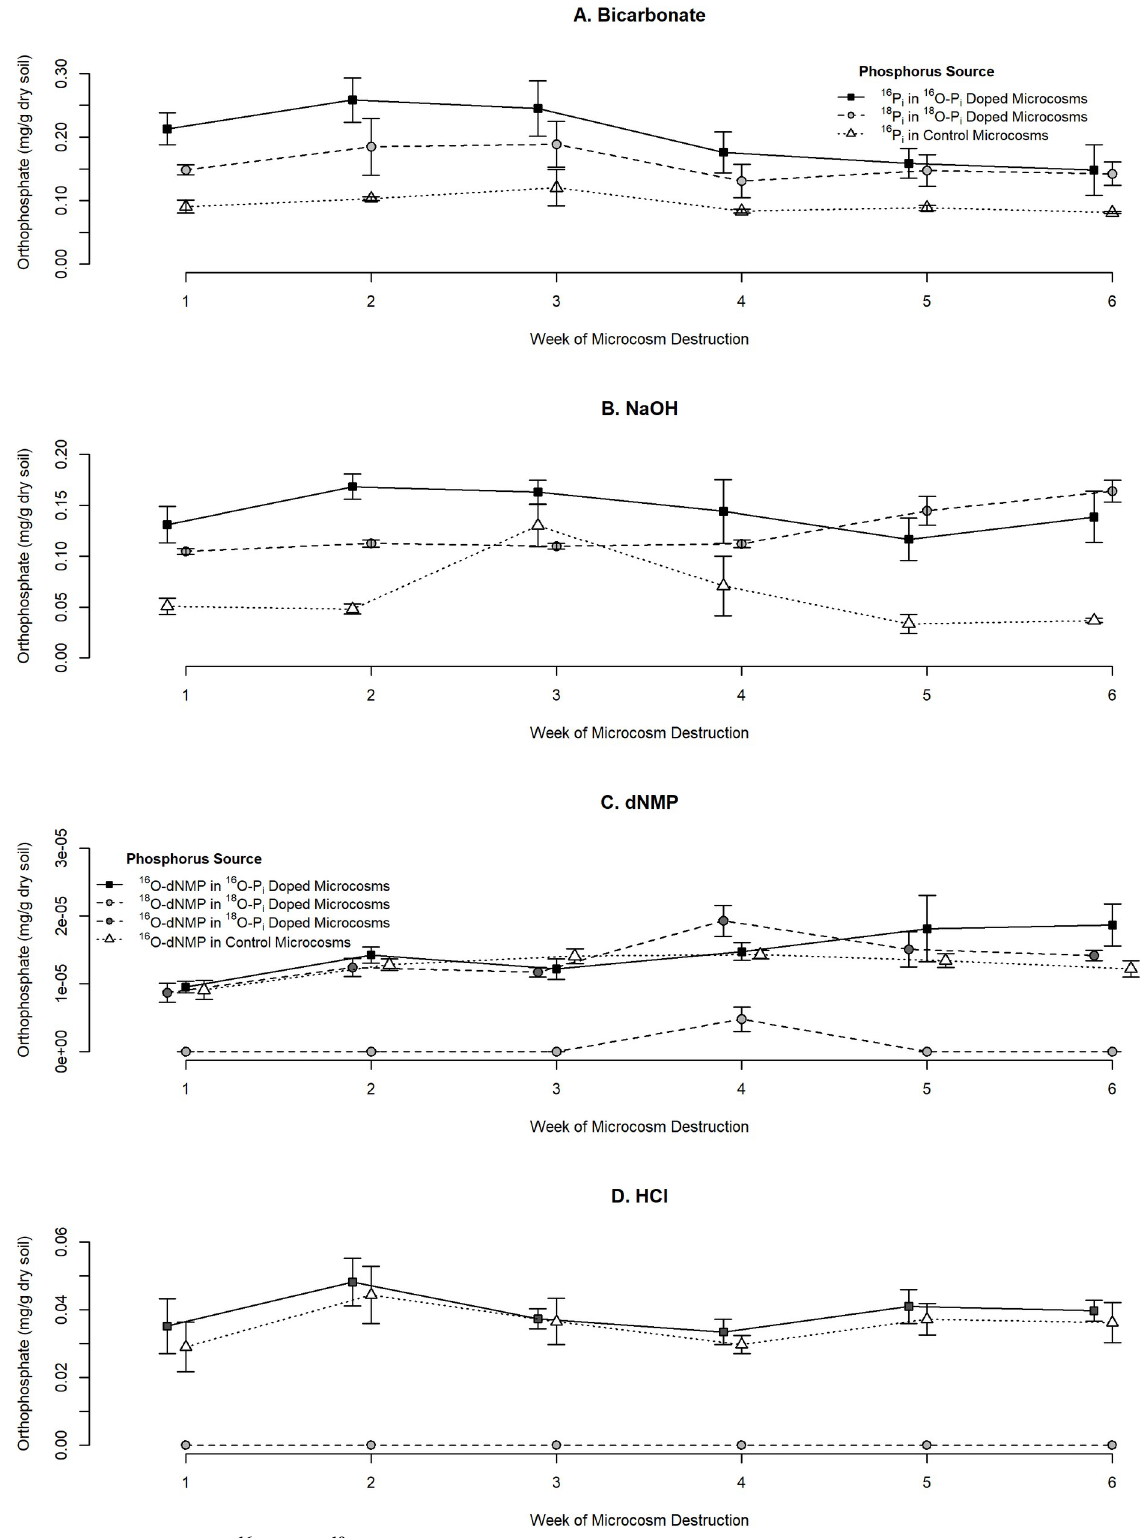
Fig 2. Temporal change in 16 O-P i and 18 O-P i in doped and control microcosms extracted by sequential fractionation. Each symbol represents the average concentration of 4 microcosms ± standard errors of the estimates. Sample means were off-set on the x-axes to see the